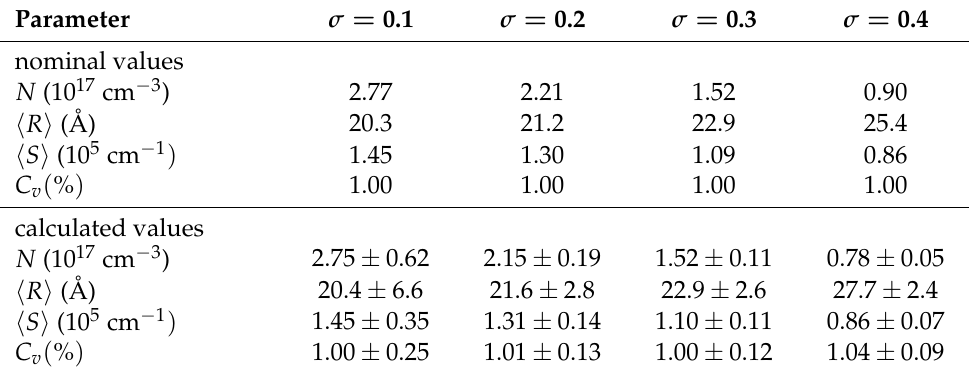
Table 2. Nominal and calculated values of the main physical quantities, the number density N , the av- erage radius (cid:104) R (cid:105) , the average surface (cid:104) S (cid:105) , and the volume fraction C v , of spherical inhomogeneities obtained by applyingthe SPA on the simulated SCS.